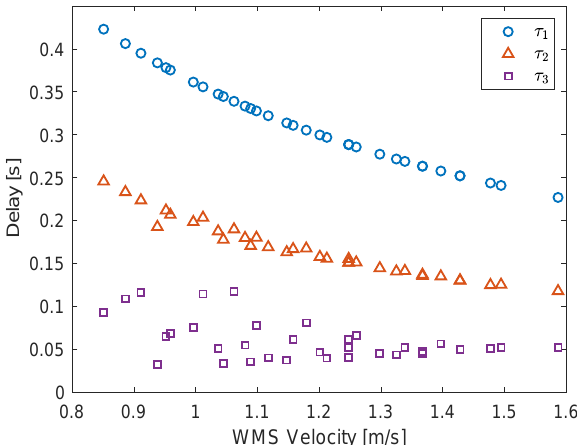
Figure A2. Components of the delay in the void fraction signal detected by the wire-mesh sensor and by the camera, predicted according to the model described in Appendix B for all the experimental points of Appendix A. The results are presented as a function of the gas velocity measured by the double-layer WMS, since it summarizes the gas and liquid flow rates into a single variable. τ 1 corresponds to the time required for the gas to move between the WMS and the swirl element; τ 2 corresponds to the time required for the gas to cross the swirl element; τ 3 corresponds to the time required for the gas to travel between the outlet of the swirl element and the